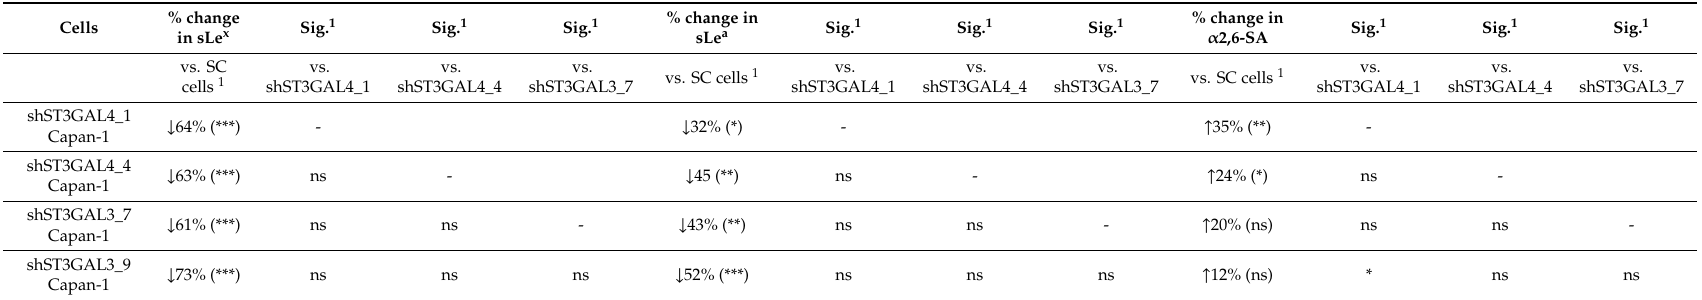
Table 2. Percentage of decrease ( ↓ ) or increase ( ↑ ) of sialylated glycan determinants in Capan-1 KD cells vs. the corresponding control (scramble) cells determined by flow